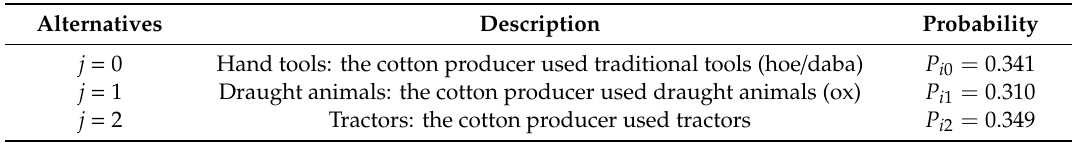
Table 3. Prediction probability of equipment